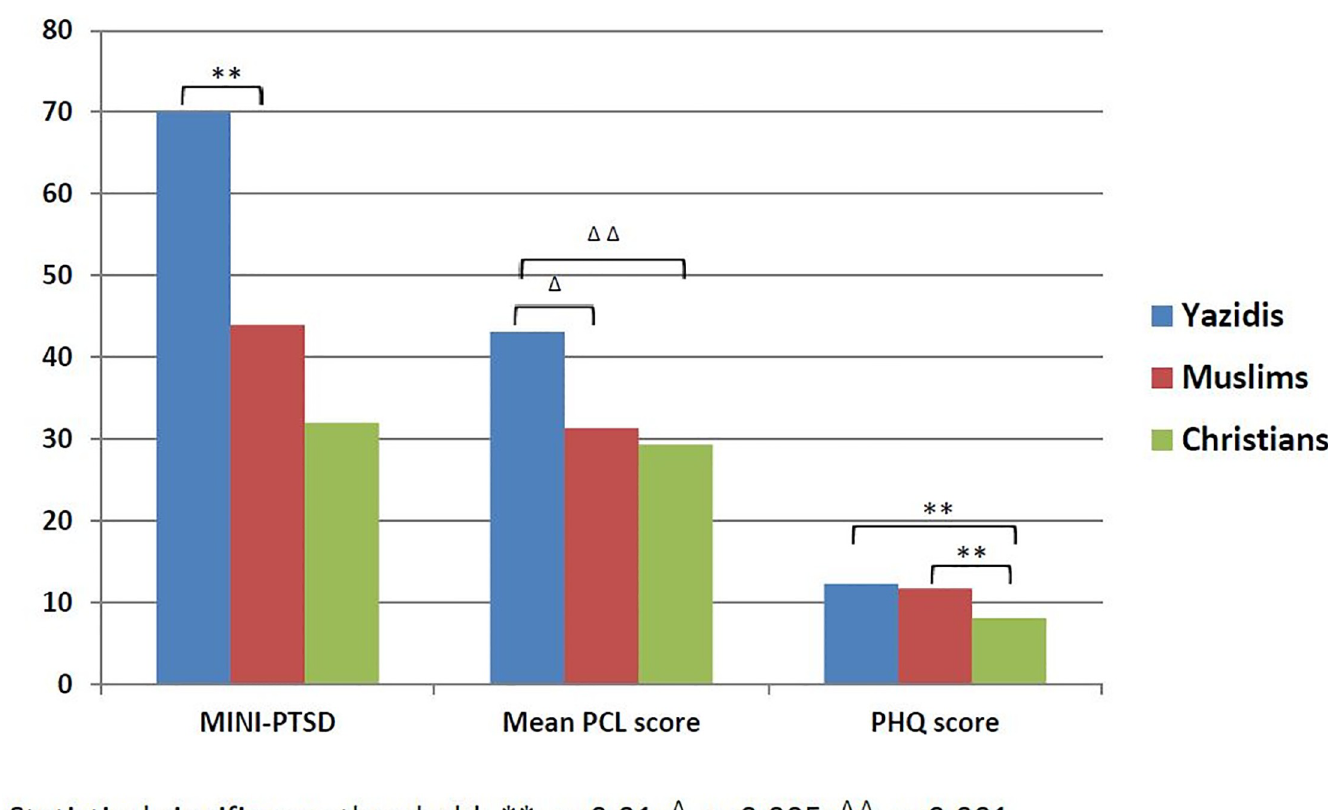
Fig 2. PTSD and depression scores according to religious affiliation.